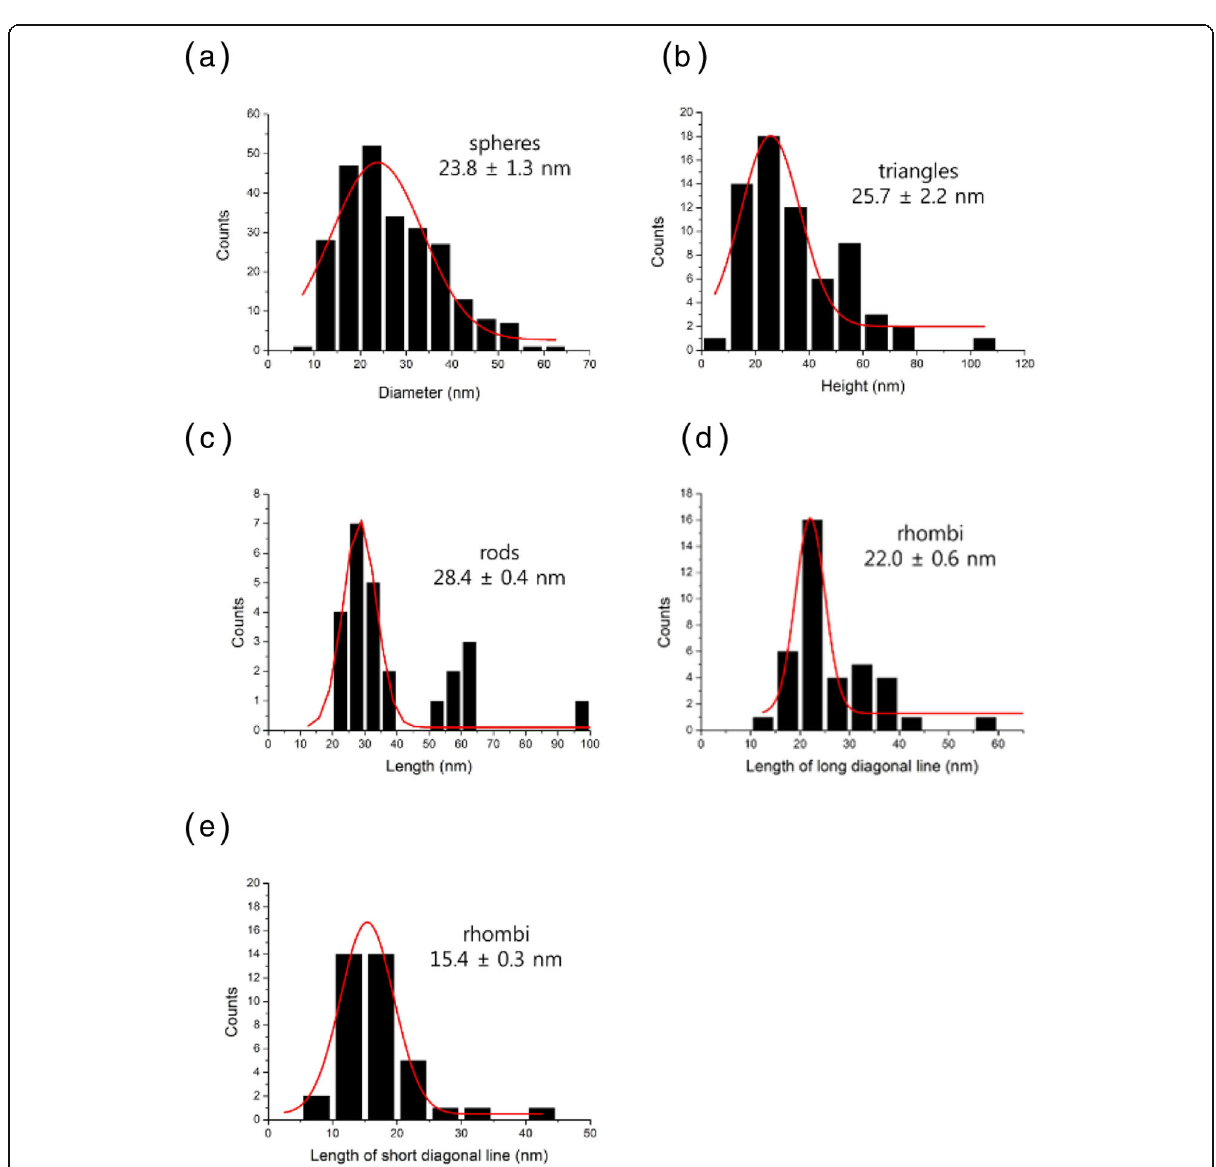
Fig. 5 Size histograms of PV-AuNPs. a The diameter of spheres. b The height of equilateral triangles. c The length of rods. d The length (long diagonal line) of rhombi. e The length (short diagonal line) of